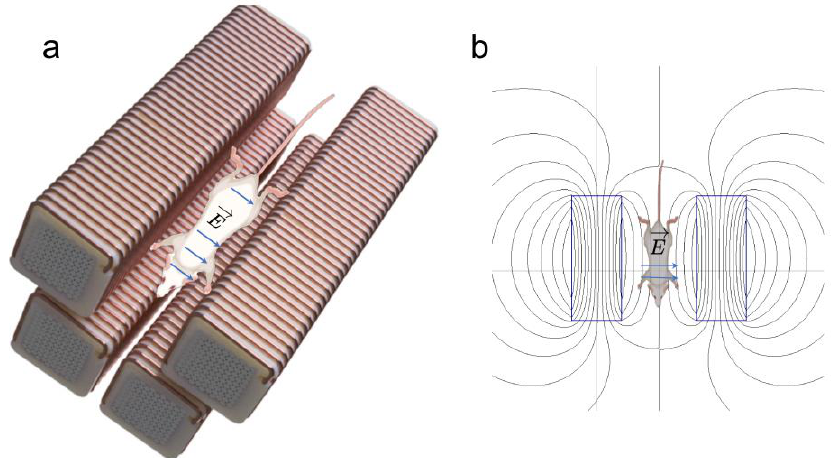
Figure 3. Murine experimental setup. ( a ) For in vivo experiments, a mouse was placed inside the four-magnet EPM array, with the length of the mouse oriented along the length of the EPM assemblies. ( b ) The EPM assemblies, shown as blue rectangles, generate magnetic fields, shown here as black lobe-shaped lines. The magnetic pulses generate electric fields (blue arrows) to which the mouse is exposed.